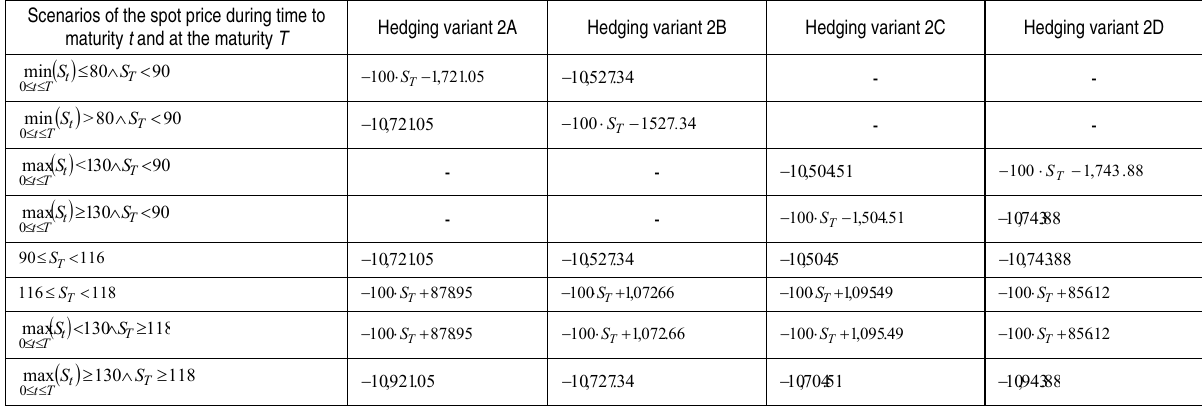
Table 2. Comparison of the profit functions for hedging variants 2A-2D Scenarios of the spot price during time to Hedging variant 2A Hedging variant 2B Hedging variant 2C Hedging variant maturity t and at the maturity T